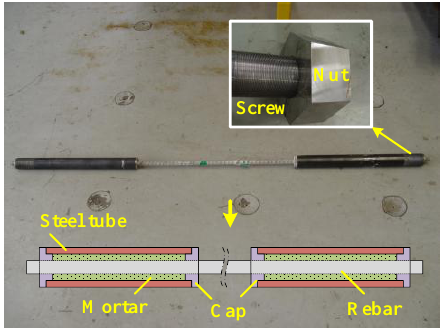
Figure 8. Preparation of specimens for tensile test.